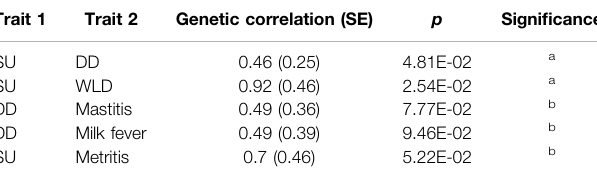
TABLE 2 | Genetic correlation estimates (and standard error, SE) between sole ulcer (SU), white line disease (WLD), digital dermatitis (DD), and other foot or health traits that were signi fi cantly or suggestively different from